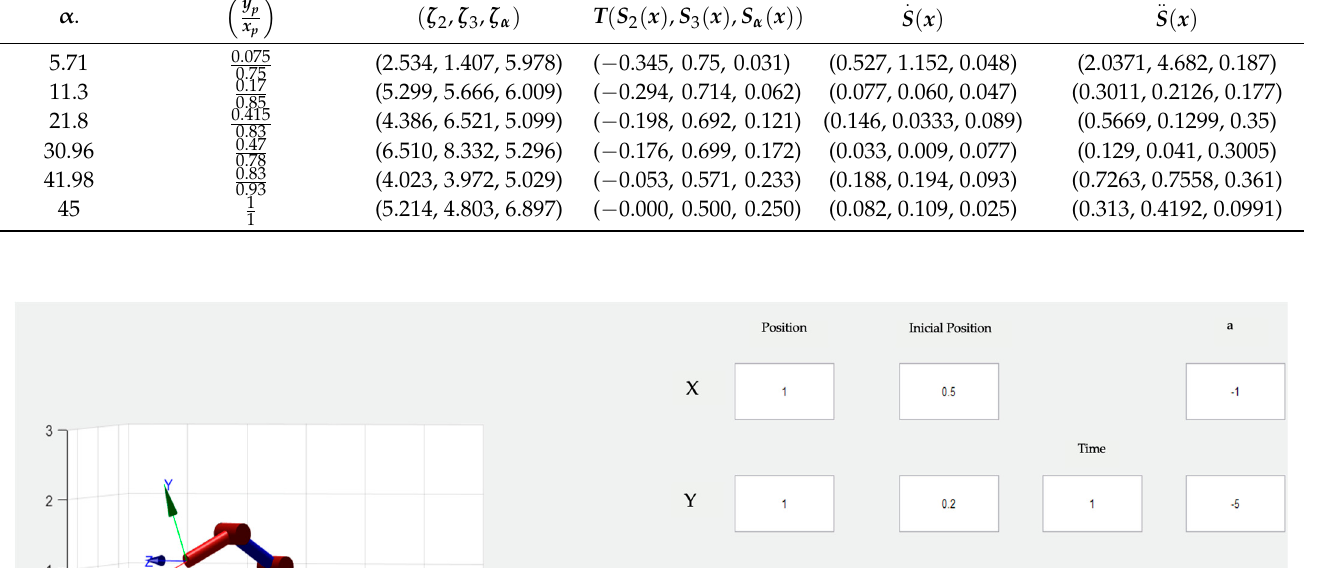
Table 1. Results of the trajectory planning in the first condition, the coordinate triangle’s area.